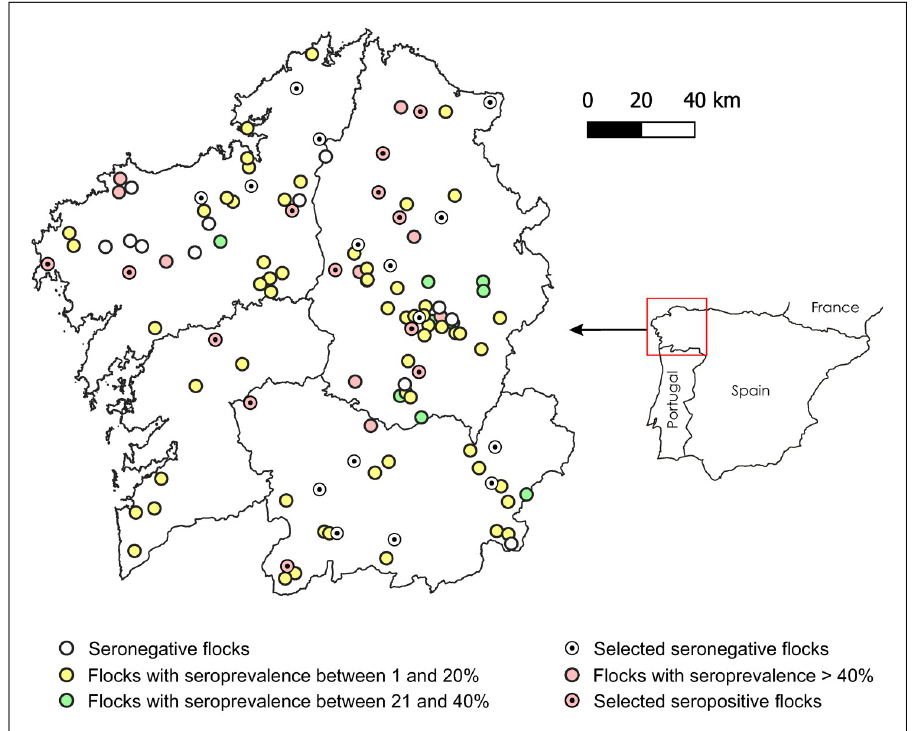
Fig 2. Map of Galicia. The location of the starting 120 sheep flocks categorized according to their anti- Fasciola antibody status is shown. The flocks finally selected for the study are also displayed. Reprinted from BDLJE under a CC BY license, with permission from ign.es, original copyright